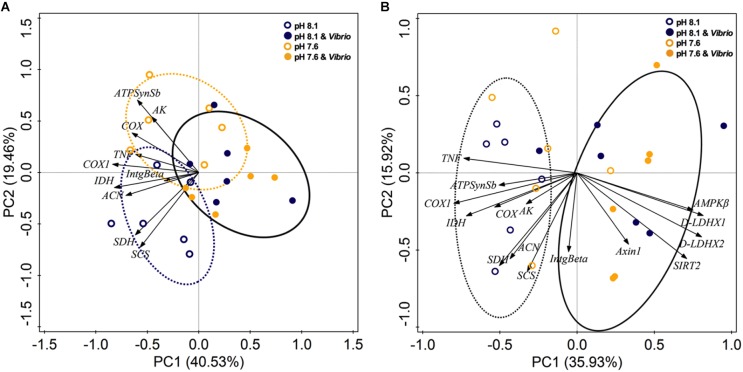
(A) Principle component analysis (PCA) ordination biplot of ocean acidification and/or V. splendidus treatments for C. gigas, using expression data of genes related to aerobic metabolism and immune responses. (B) PCA ordination biplot of ocean acidification and/or V. splendidus treatments for C. gigas, using expression data of genes related to energy metabolism and immune responses.